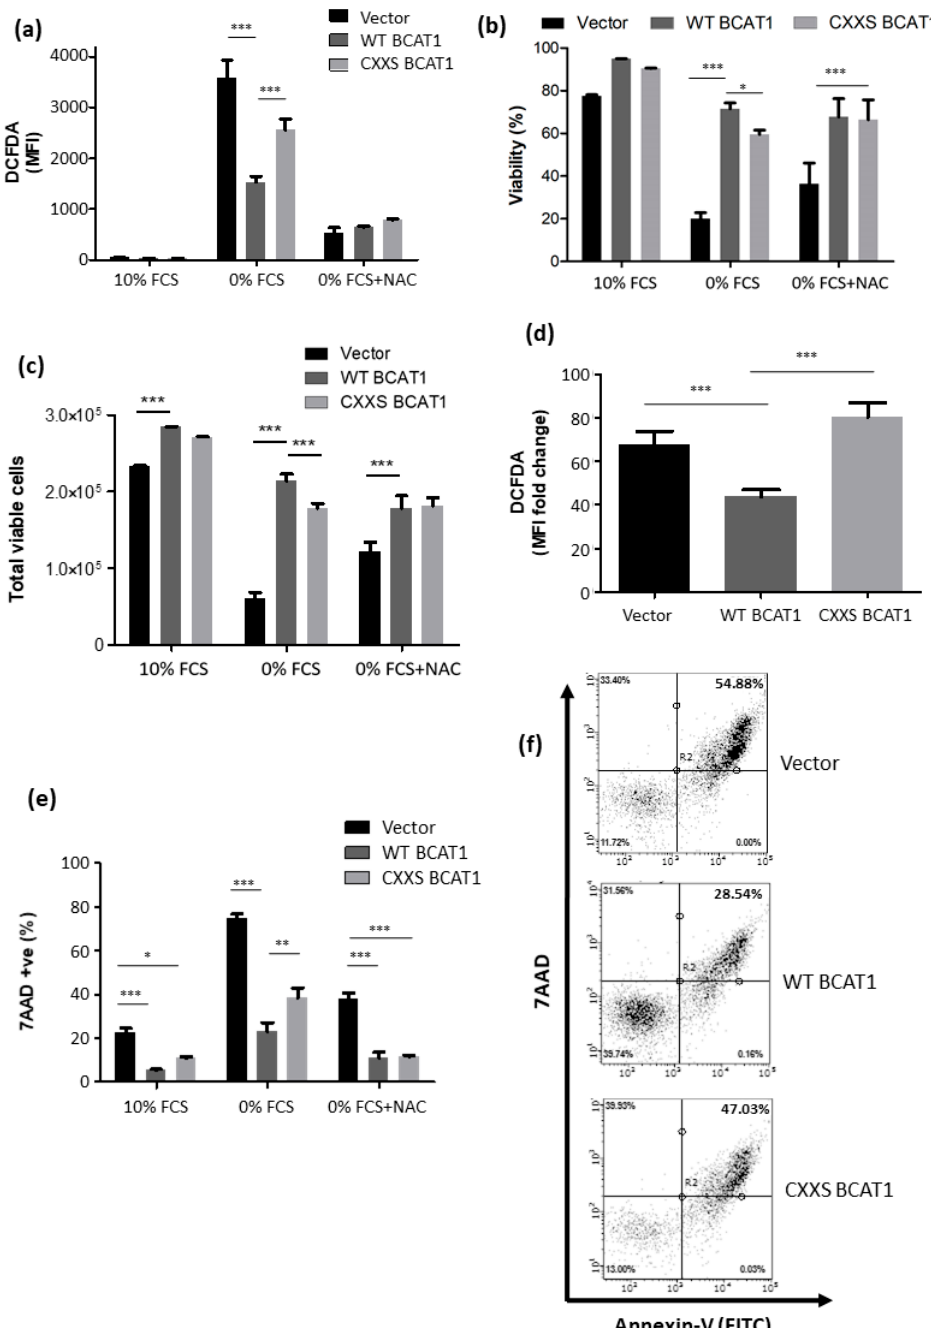
Figure 5. BCAT1 CXXC motif increases survival and modulates intracellular ROS following serum deprivation induced oxidative stress in U937 cells. Serum deprivation-induced by incubation with RPMI ± 10% Foetal Calf Serum (FCS) + 10 mM N-acetyl cysteine (NAC) for 72 h. ( a ) Bar chart displaying DCFDA serum deprivation and NAC treatment at 72 h. ( b ) Cell viability following serum depletion and NAC treatment at 72 h. ( c ) Cell density analysis following serum depletion and NAC treatment at 72 h. ( d ) Fold change in DCFDA signal for Vector Control, WT BCAT1, and CXXS BCAT1 cells following serum deprivation for 72 h. ( e ) Bar chart displaying late apoptotic cells measured by flow cytometry at 72 h. ( f ) Representative flow cytometric plots displaying viable (lower left quadrant), early apoptotic (Annexin-V positive, upper left quadrant), and late apoptotic (7AAD positive, upper right quadrant) cells at 72 h. Data presented are mean SD. Significant differences were calculated ± using 2-way ANOVA with Bonferroni post-test where * p < 0.05, ** p < 0.01, and *** p < 0.001 ( n = 3). See Supplemental Figure S2 for the NAC dose-response and Supplemental Figure S3 for the trends at 48